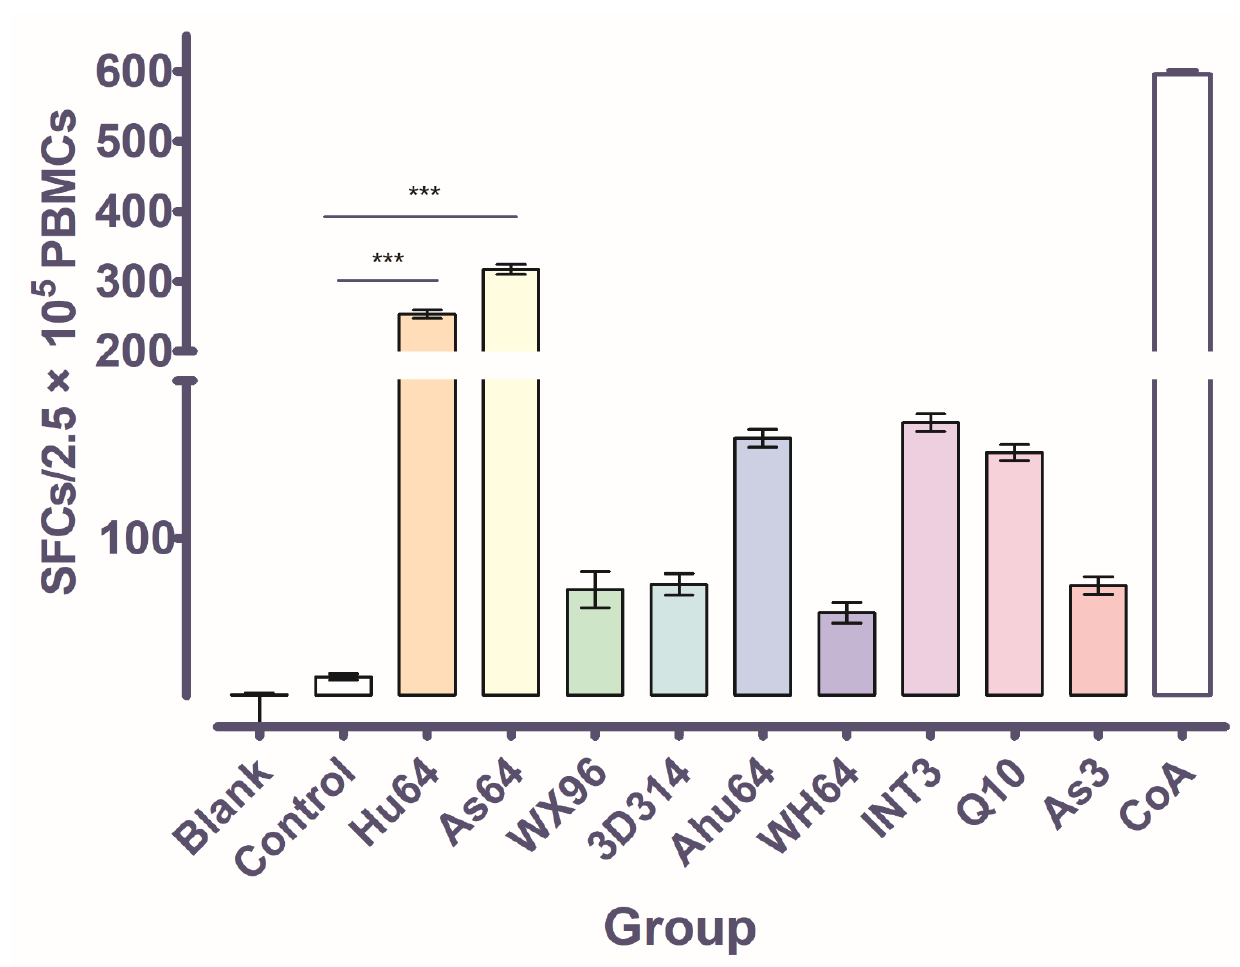
Figure 7. Detection of the peptides that induce CTLs to release IFN- γ by ELISPOT. The break in the y axis indicates a threshold value that can be judged as an effective peptide in the assay. *** indicates the dominant peptides that can induce a superior CTL response. A blank group denotes that there are no peptides detected in the wells of the plates. The control group denotes that the negative peptide control was added to the wells to induce CTLs to release IFN- γ . The CoA group represents the positive control for nonspecific stimulation. The name of each peptide group denotes that a specific peptide was added to the well to induce CTLs to release IFN- γ , and it was detected by